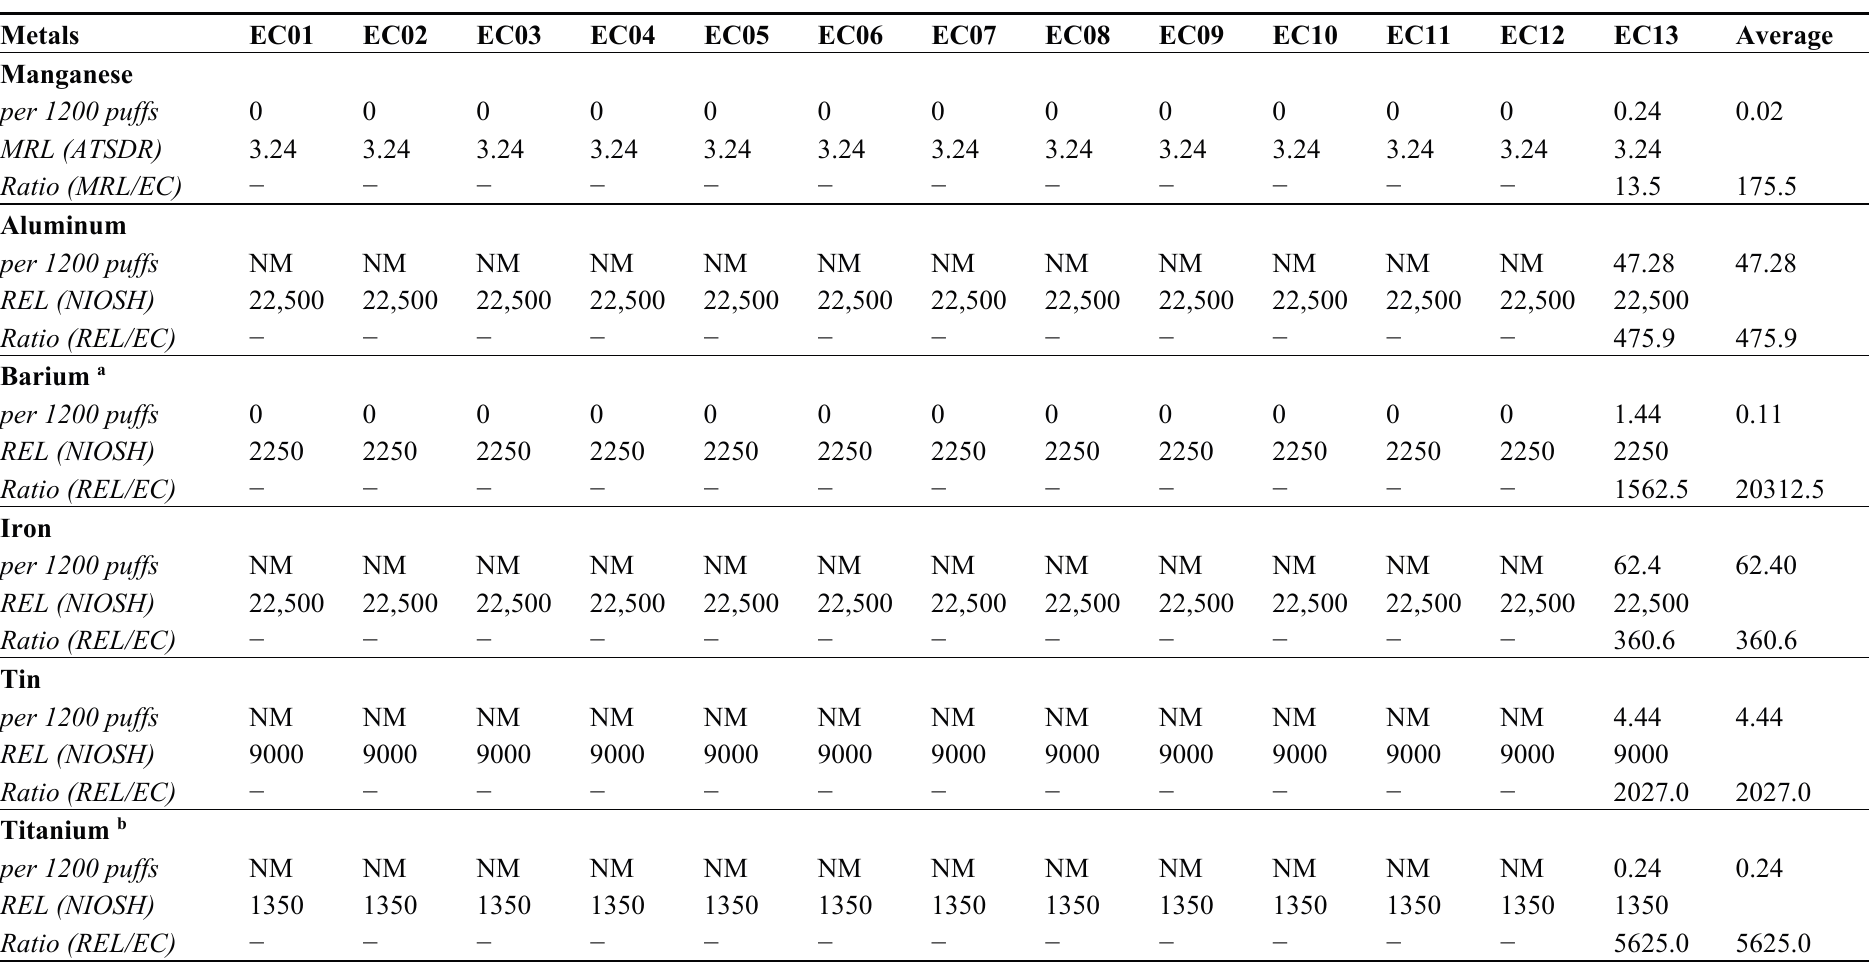
Table 2. Exposure to metals from electronic cigarette use in comparison with regulatory safety limits from the secondary analysis (assuming a resting 10.3 m 3 and 4.5 m 3 respiratory volumes in 24-h and 10-h respectively); all values are in μ g; the metals analyzed based on United States Pharmacopeia Permissible Daily Exposures (PDEs) are not presented because PDEs are defined as level of exposure per day, irrespective of the respiratory volume (see Table